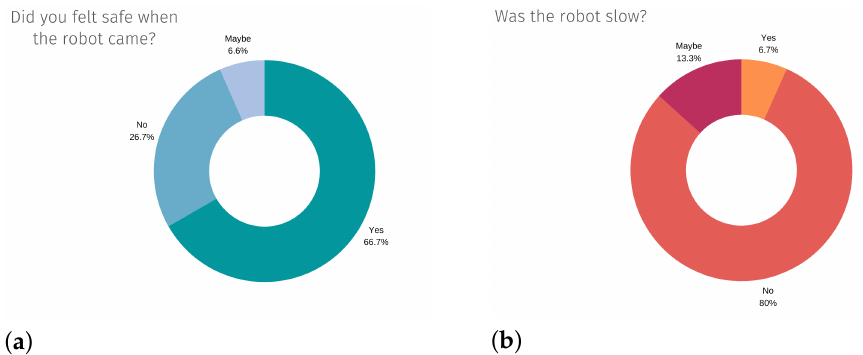
Figure 6. ( a ) Question about invulnerability; ( b ) question about reaction time.